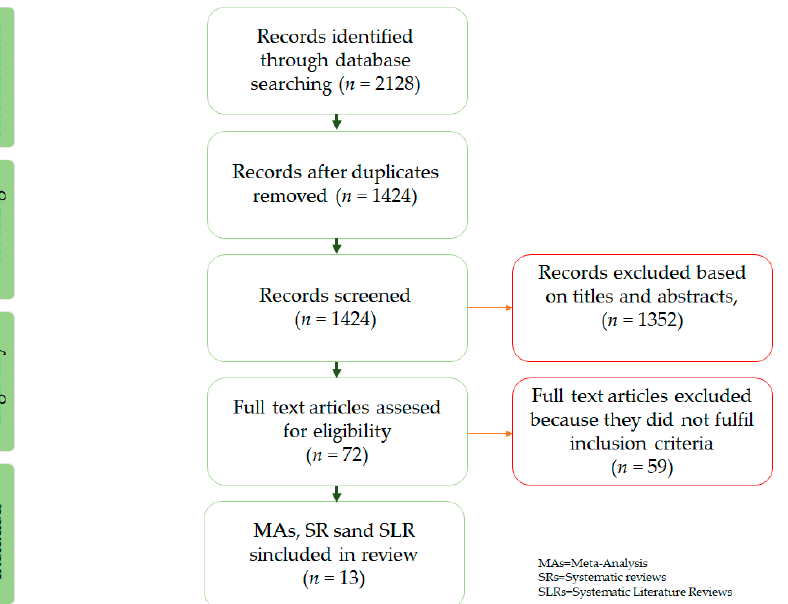
Figure 2. Flow diagram of literature search to identify Meta-Analysis and Systematic reviews evaluating the effect of Mediterranean diet on glycemic control in type 2 diabetes mellitus and diabetes prevention.